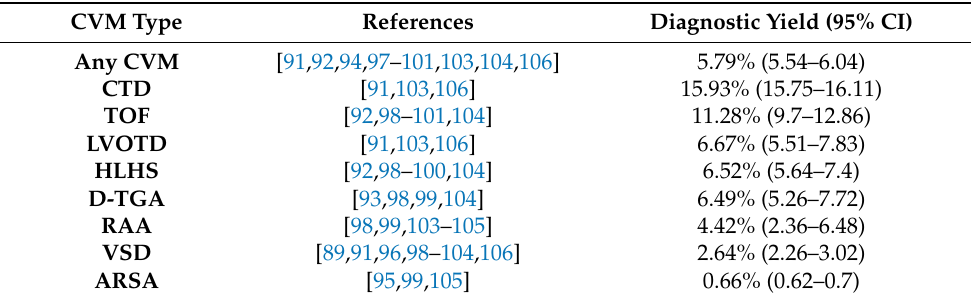
Table 2. Meta-analysis of each subgroup of CVM.